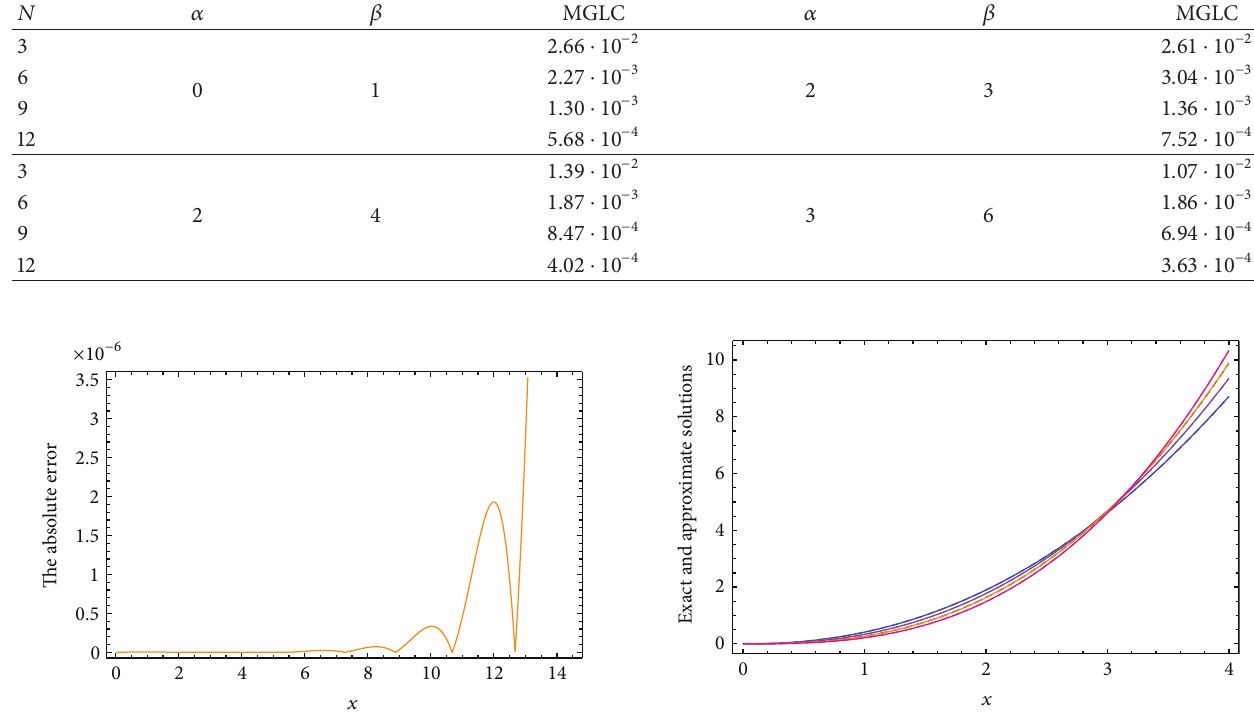
Table 5: Maximum absolute error for ] = 3/2 , with various choices of 𝑁 , for Example 9 in which 𝑥 ∈ (0, 1) .